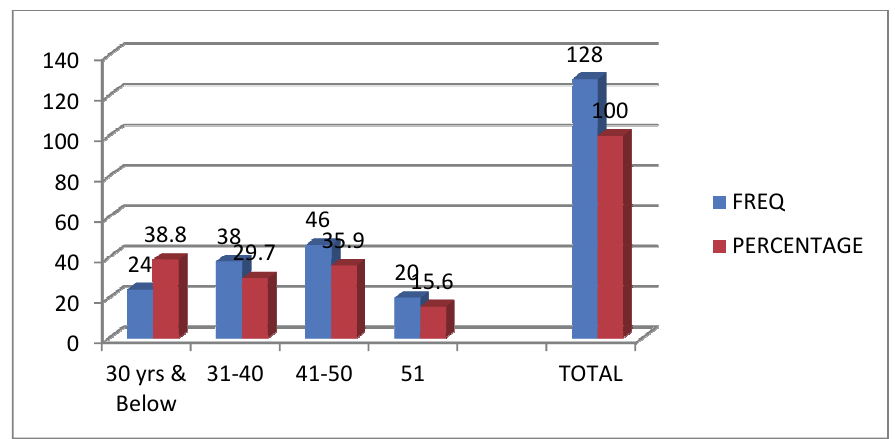
Source: Field Survey November, 2014